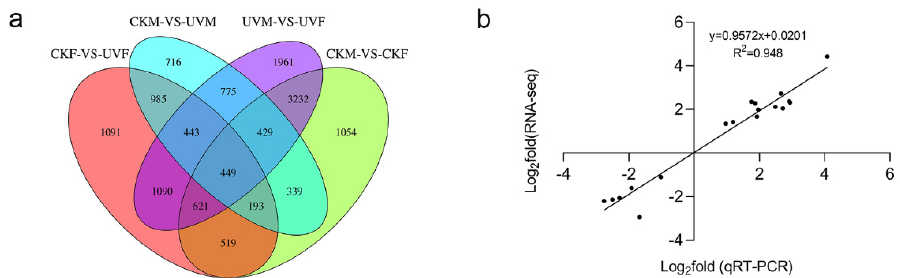
Figure 3. Venn diagram of differentially expressed genes in the four comparisons and validation of the RNA-seq results. ( a ) Numbers of genotype-specific and common DEGs. ( b ) Correlation analysis between the RNA-seq and qRT-PCR